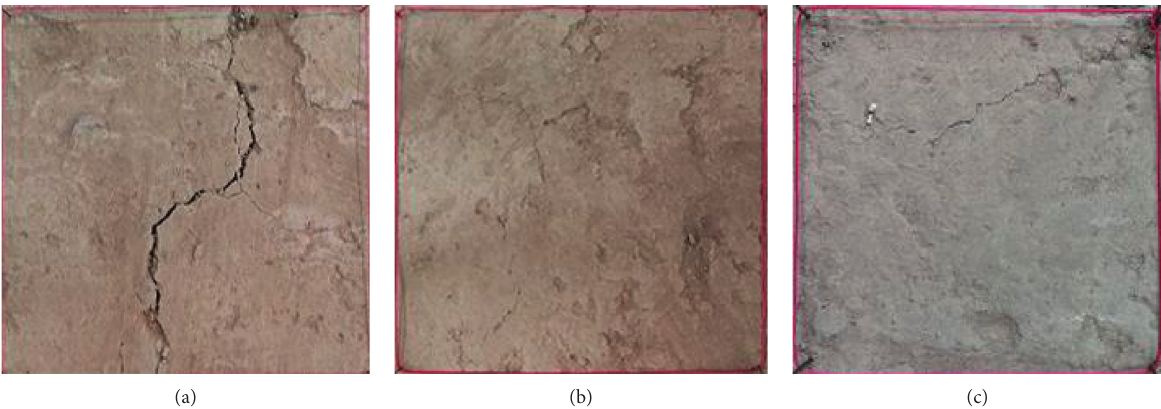
Figure 22: Observed cracks on the surface of base course. (a) Cemented soil. (b) Solidified soil. (c) Fiber-reinforced soil.